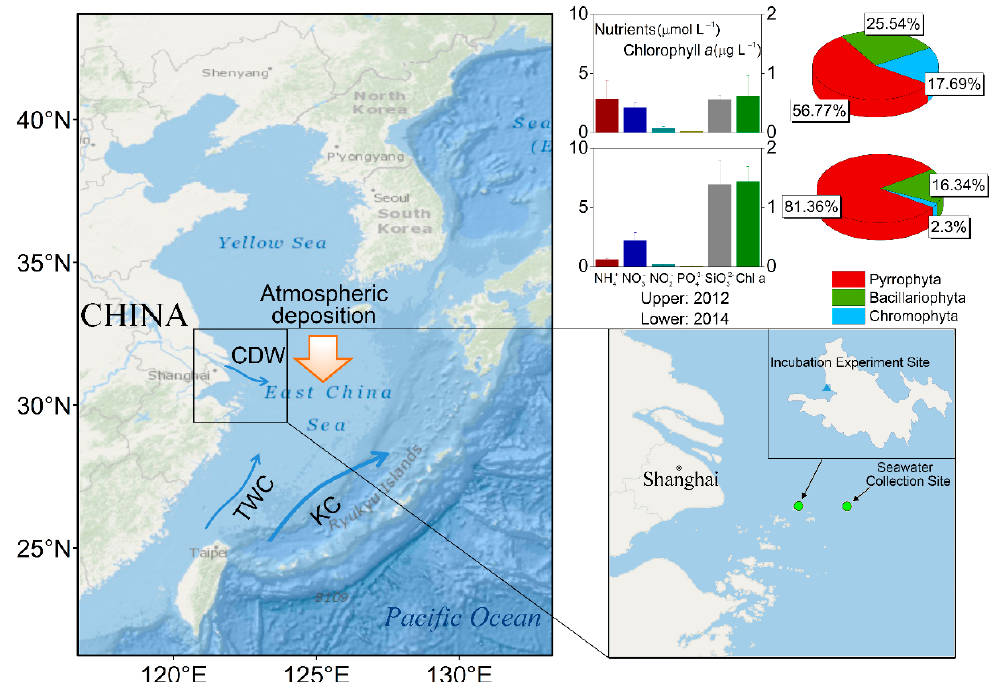
Figure 1. Sites for water collection and incubation experiments and the initial nutrients levels and phytoplankton community structure in natural seawater. The major species (quantitatively >5% of the total cell number) included Alexandrium tamarense (dinoflagellate), Dictyocha speculum (Chromophyta), Scrippsiella trochoidea (dinoflagellate), Pleurosigma pelagicum (diatom), and Gonyaulax verior (dinoflagellate) in the initial seawater for the 2012 experiment and Karenia mikimotoi (dinoflagellate), Gyrodinium instriatum (dinoflagellate), Prorocentrum donghaiense (dinoflagellate) , Gyrodinium spirale (dinoflagellate), and Pheopolykrikos hartmannii (dinoflagellate) in the initial seawater for the 2014 experiment. The base map was obtained from Environmental Systems Research Institute (ESRI) online